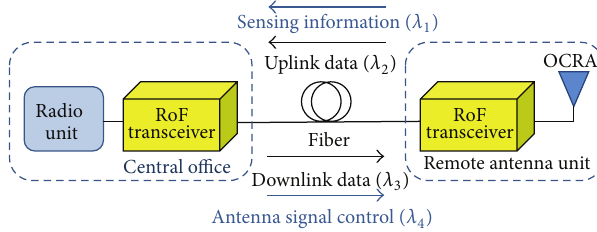
Figure 1: Schematic of OCRA implementation.